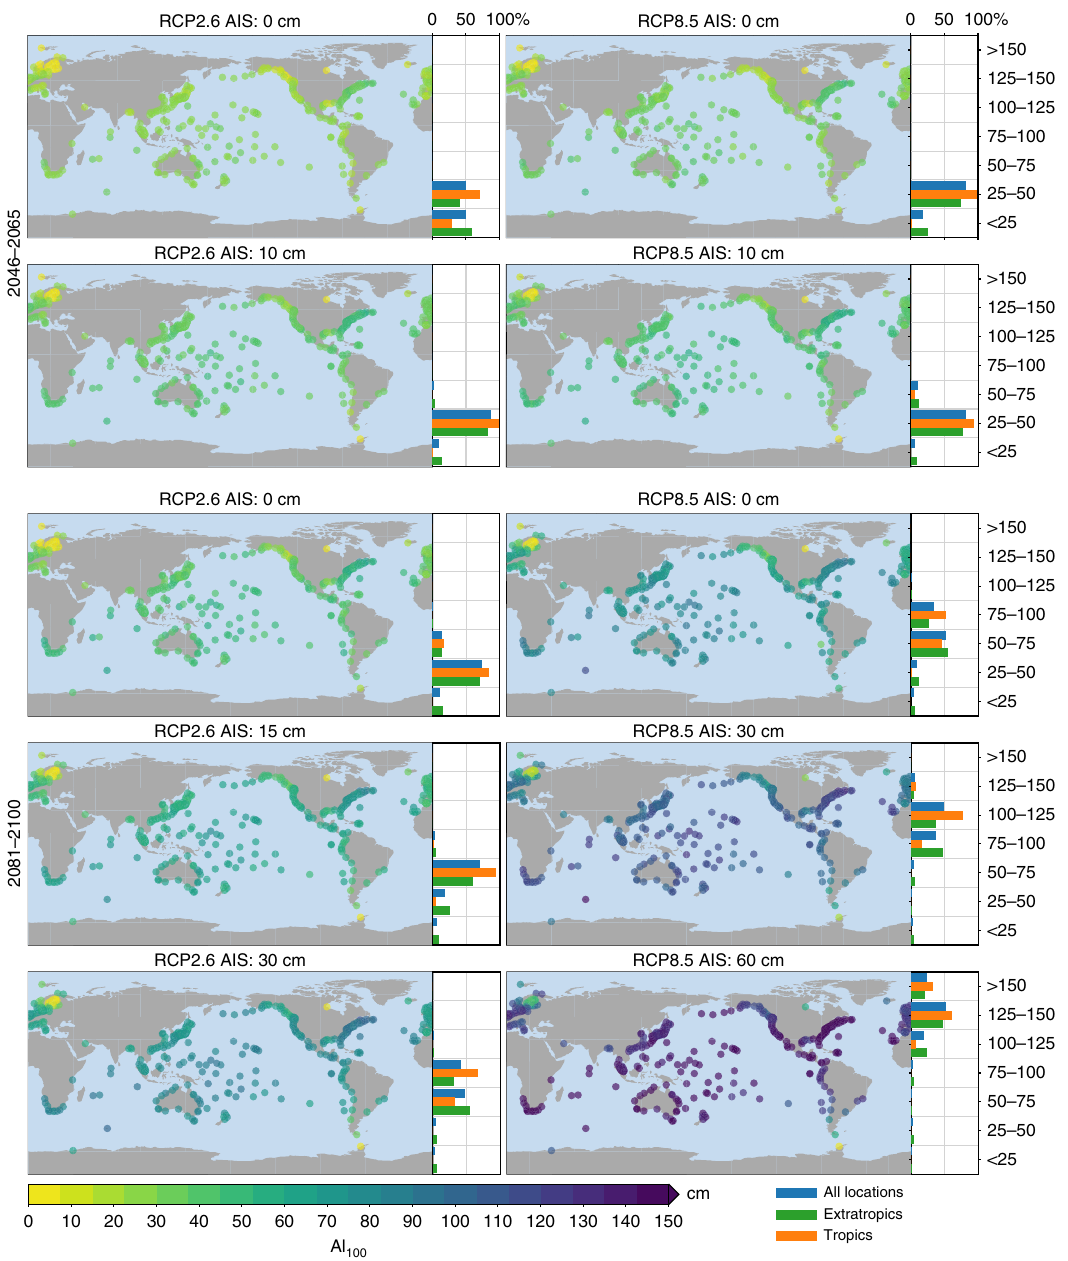
Fig. 5 Allowances for the 100-year extreme sea-level event. The bars on the right show the histogram of the allowances, separated into stations in the tropics (latitude between ±23.44°), extratropics (latitude outside ±23.44°), and all stations. See Supplementary Figs. 8 and 9 for the allowances for all scenarios and AIS